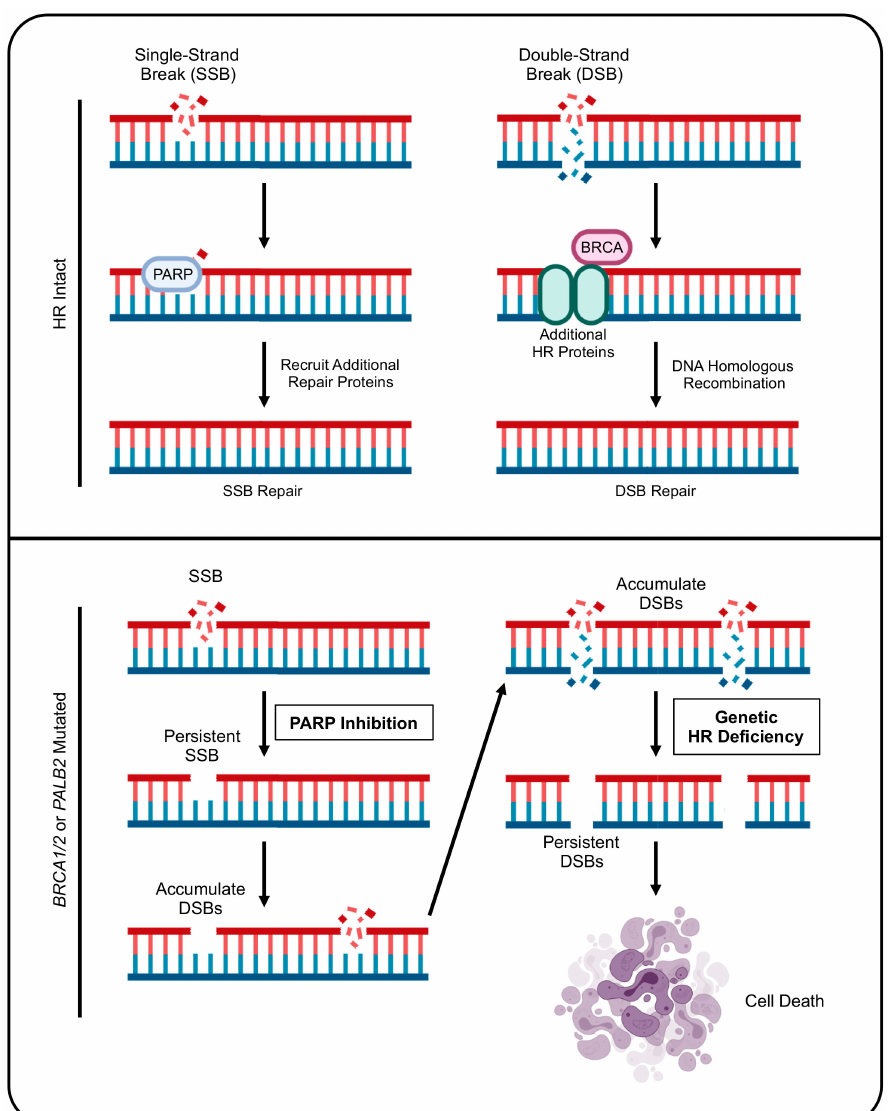
Figure 1. Molecular basis for the efficacy of PARP inhibition in HR-deficient tumor cells. In